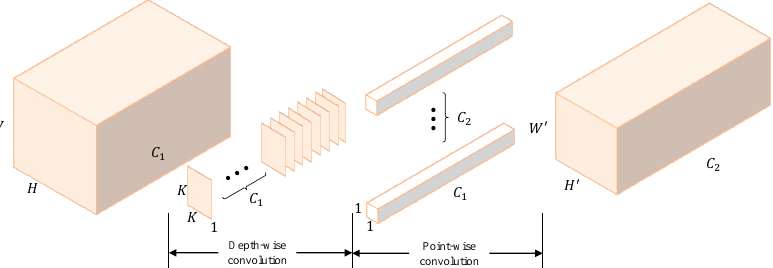
Figure 2. Diagram of the depth-wise separable convolution. A depth-wise convolution and a point- wise convolution are employed successively, which not only bring about similar effects to traditional convolution, but also reduce the number of